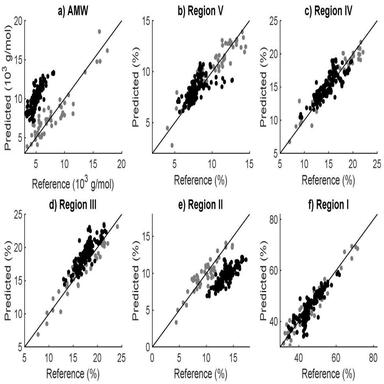
Predicted versus reference values from PLS regression models based on FTIR spectra. Separate models were made for AMW (b) and the five molecular weight regions (b–f) corresponding to those shown in. The models were optimised by cross-validation using a set of hydrolysates produced in the laboratory (grey dots) and tested on a set of hydrolysates collected from industry (black dots). Detailed model characteristics are given in Table 1.